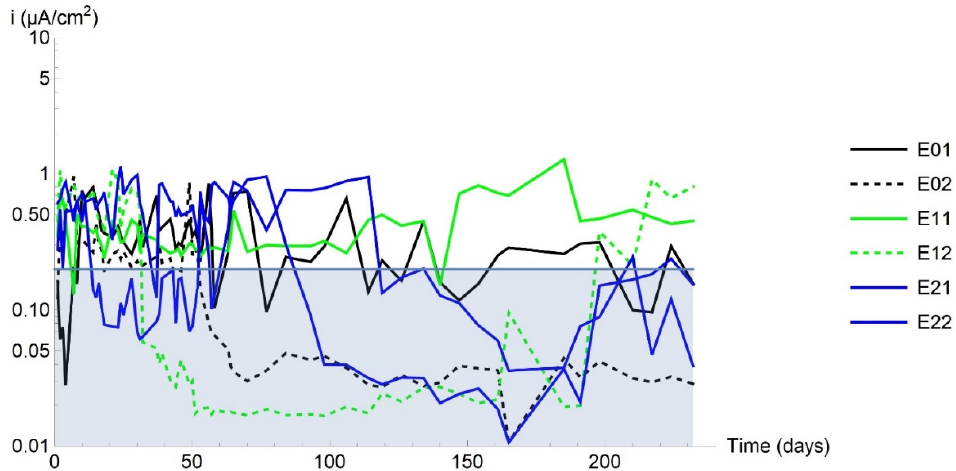
Figure 7. Corrosion rate over time in all the tested specimens.